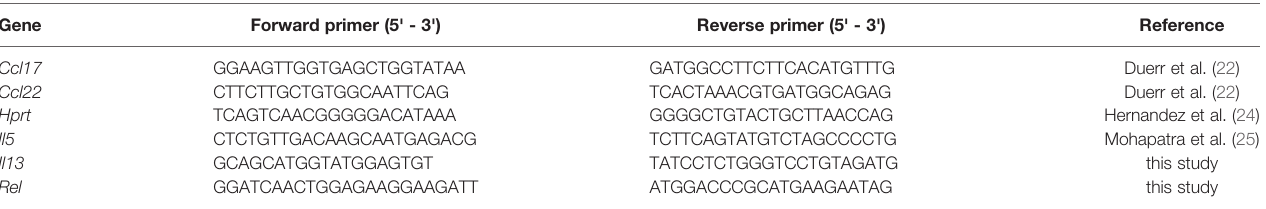
TABLE 2 | qRT-PCR